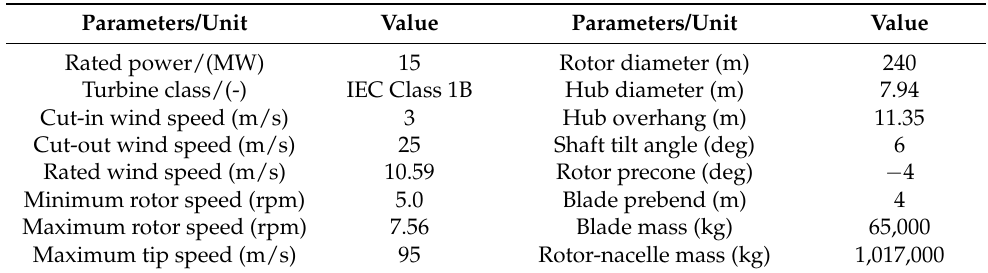
Table 1. Main design parameters of the IEA 15 MW reference wind turbine.